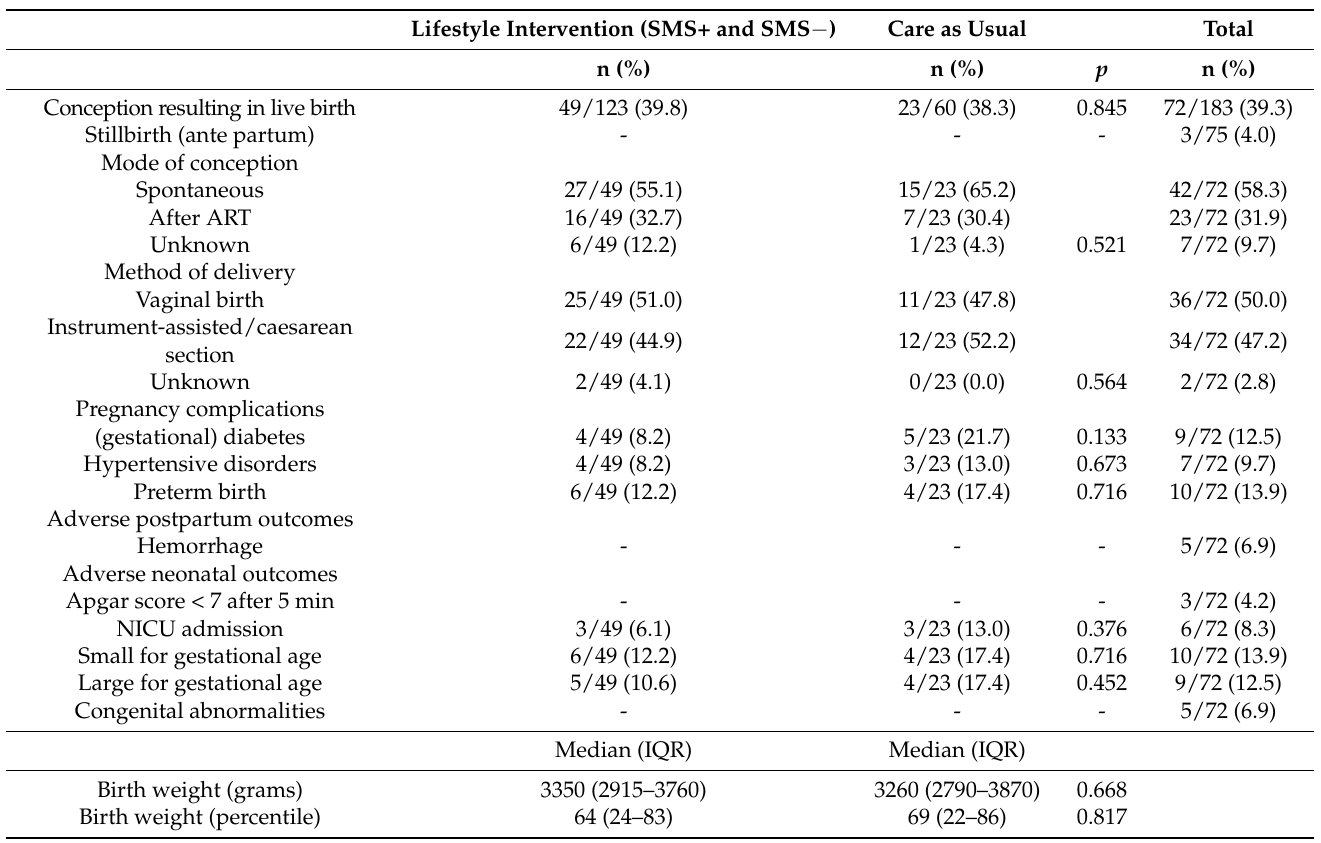
Table 2. Pregnancy outcomes within 24 months after the start of the